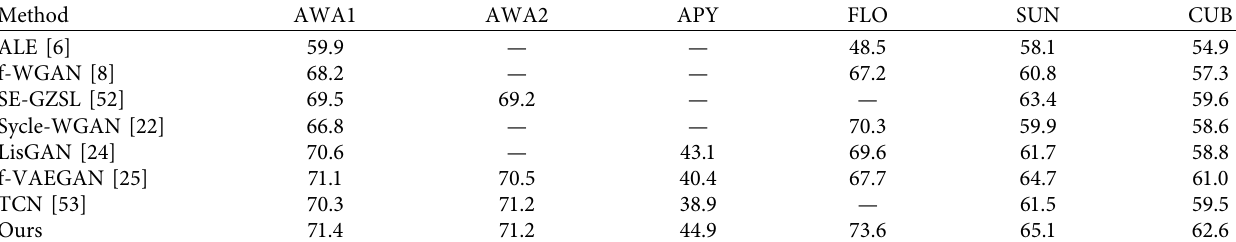
Table 2: Results of ZSL on six classification benchmarks. ZSL measuring per-class average top-1 accuracy (T1) on c there are no relevant results in the reference, while the underlined results are reproduced according to the description of